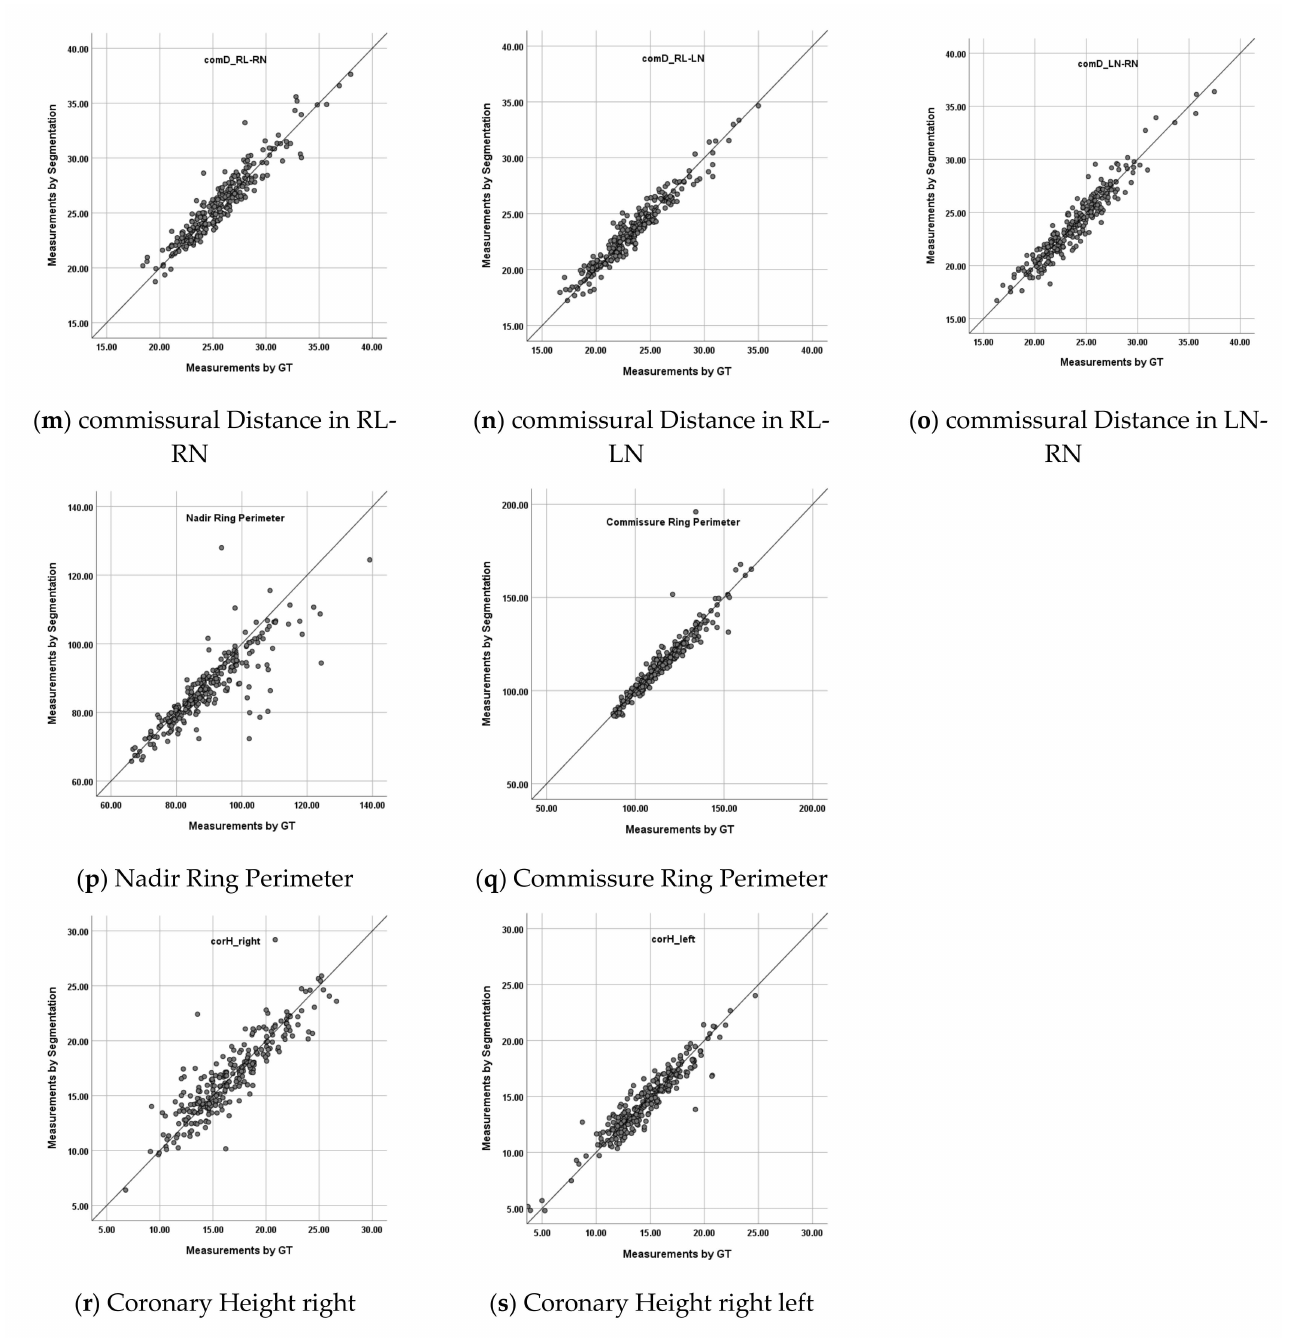
Figure A1. Scatterplots for correlation for each measurement item: ( a ) effective Height in RCC, ( b ) effective Height in LCC, (c) effective Height in NCC, ( d ) geometric Height in RCC, ( e ) geometric Height in LCC, ( f ) geometric Height in NCC, ( g ) cusp insertion Length in RCC, ( h ) cusp insertion Length in LCC, ( i ) cusp insertion Length in NCC, ( j ) Free Margin Length in RCC, ( k ) Free Margin Length in LCC, ( l ) Free Margin Length in NCC, ( m ) commissural Distance in RL-RN, ( n ) commissural Distance in RL-LN, ( o ) commissural Distance in LN-RN, ( p ) Nadir Ring Perimeter, ( q ) Commissure Ring Perimeter, ( r ) Coronary Height right, ( s ) Coronary Height right